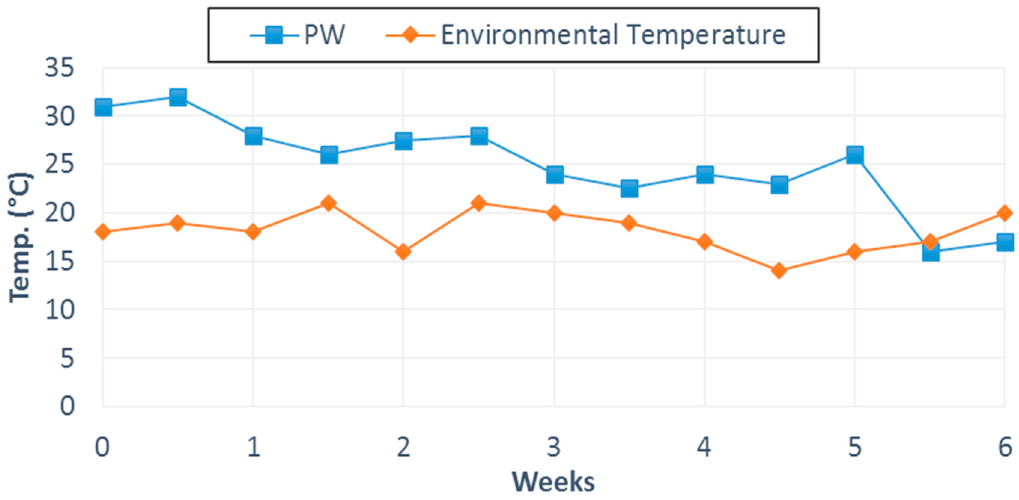
Figure 1. Pineapple waste temperature (PW) behavior and environmental temperature during the pre-composting process.